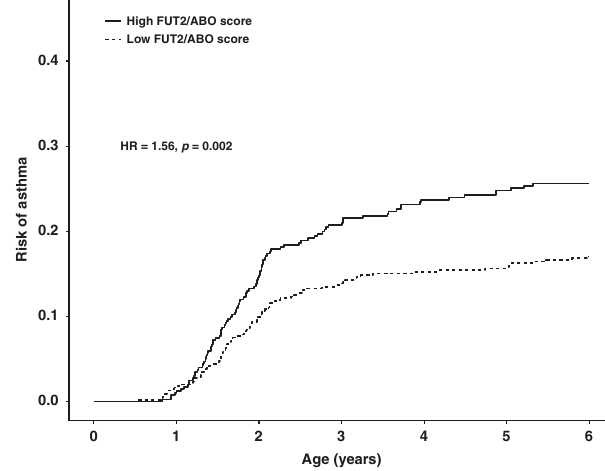
Fig. 4 Kaplan – Meier curve illustrating the effect of the FUT2 – ABO risk score on estimated risk of childhood asthma in the COPSAC birth cohorts (replication). A high FUT2 – ABO score corresponds to individuals with a score > 0, and a low score corresponds to the remaining individuals with a score < 0. Hazard ratio and P value are estimated using a Cox proportional- hazard model. The model was adjusted for sex and cohort status. N = 918 ( N cases = 191, N controls = 727). The FUT2 – ABO score was based on rs601338 ( FUT2 ) and rs505922 ( ABO